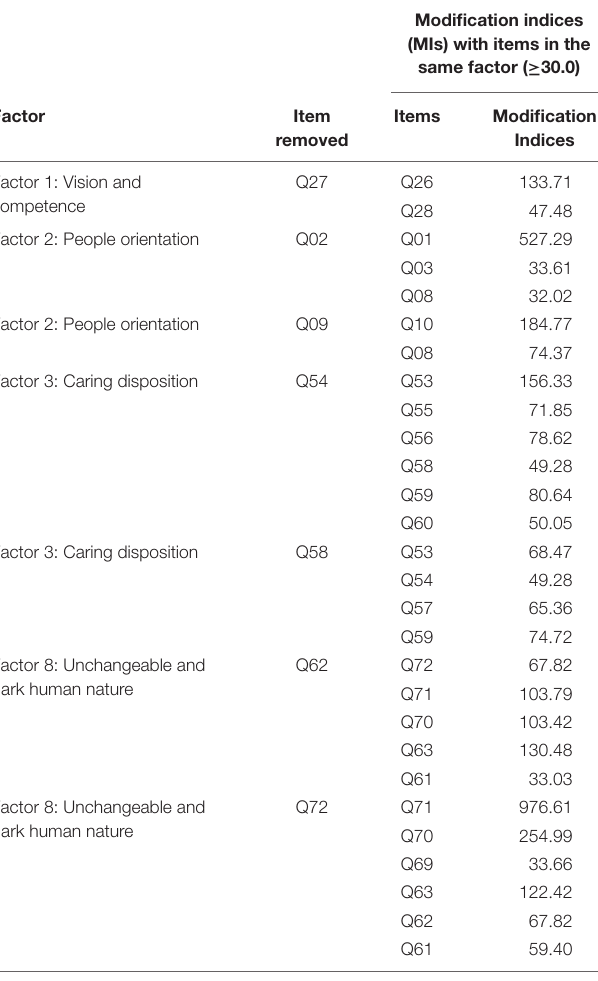
TABLE 3 | Seven items removed from the eight-factor 53-item model of SLA due to extreme modification indices ( ≥ 30.0).